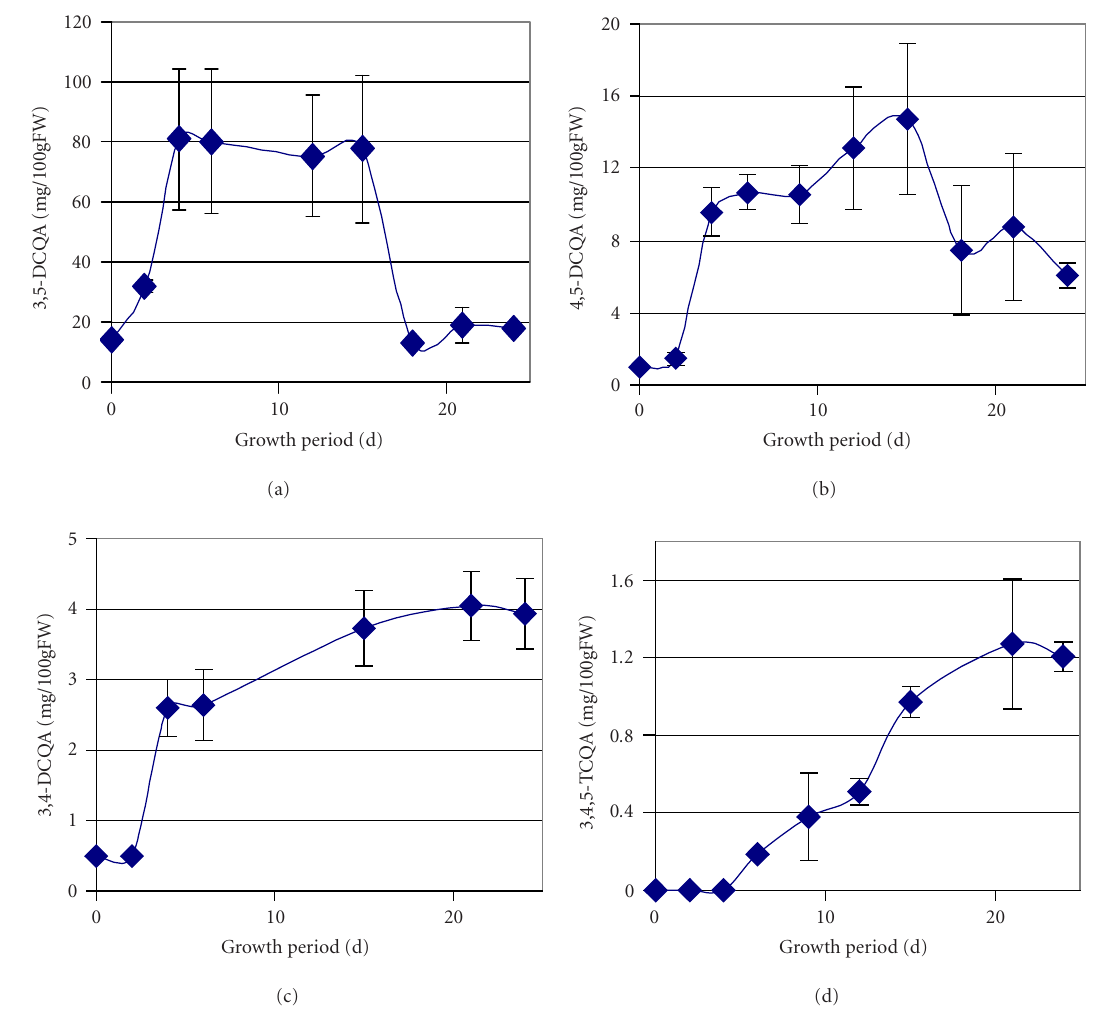
Figure 2. Accumulation of (a) 3,5-dica ff eoylquinic acid (3,5-DCQA), (b) 4,5- dica ff eoylquinic acid (4,5-DCQA), (c) 3,4-dica ff eoyl- quinic acid (3,4-DCQA), (d) 3,4,5-trica ff eoylquinic acid (3,4,5-TCQA) in the PL suspension culture over one growth period in a high-anthocyanin producing medium (APM). Bars represent standard deviations of six